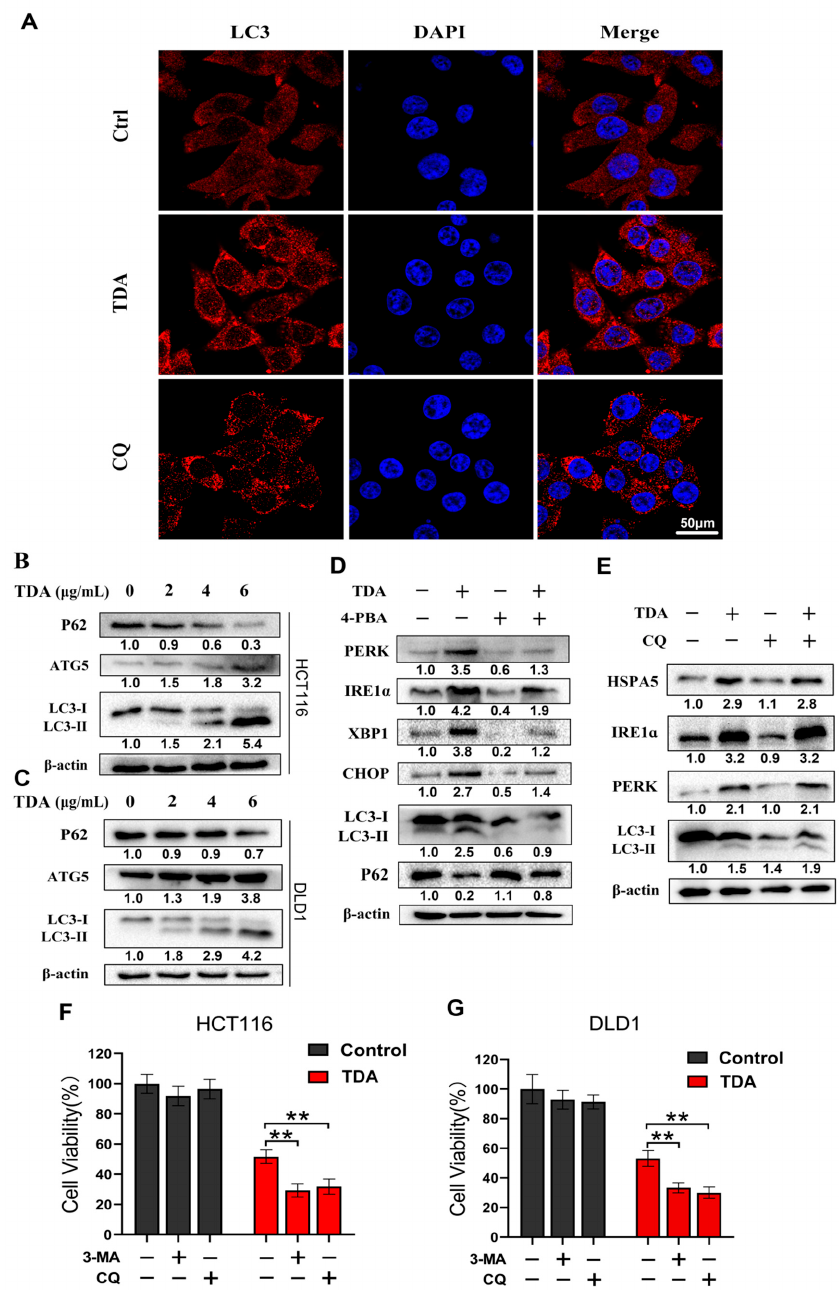
Figure 5. TDA induces autophagy in colon cancer cells. ( A ) Analysis of autophagy induction by immunofluorescence staining of LC3B in HCT116 cells, which were treated with TDA (3 µ g/mL) for 24 h. CQ (10 µ M) was treated for 24 h as a positive control. ( B , C ) The protein expression levels of P62, ATG5 and LC3 in TDA-treated HCT116 or DLD1 cells were detected by Western blot. ( D ) Immunoblotting of PERK, IRE1 α , LC3 and P62 in HCT116 cells treated with TDA, 4-PBA alone or together as indicated for 24 h. ( E ) Immunoblotting of HSPA5, PERK, IRE1 α and LC3B in HCT116 cells treated with TDA, CQ alone or together as indicated for 24 h. ( F , G ) HCT116 and DLD1 cells were treated with TDA alone or combination with autophagy inhibitors 3-MA or CQ as indicated. Cell viability was measured by CCK-8 assay. Cells were pretreated with 3-MA (1 mM) or CQ (10 µ M) for 4 h, followed by TDA (6 µ g/mL) treatment for 24 h. Data are presented as mean ± SD. ** p < 0.01. Western blot results were quantified using software Image J v1.8.0 (National Institutes of Health, USA) and the results were numerically marked below each